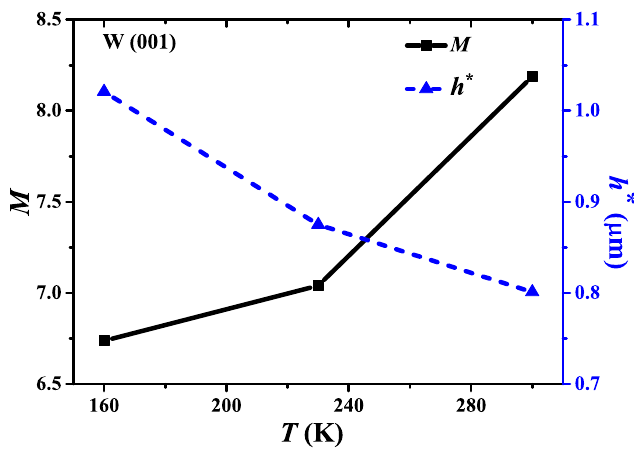
Figure 4. (Color online) Evolution of M and h ∗ as a function of T for single crystal W.